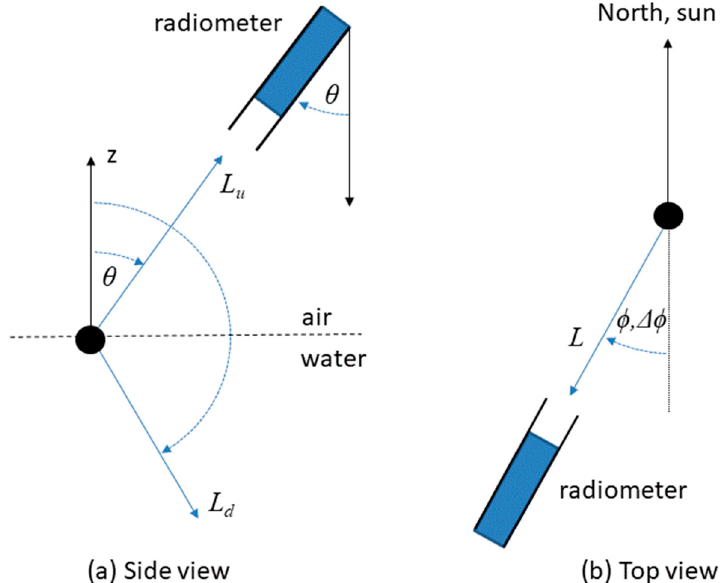
Figure 1. Nadir and azimuth viewing angle conventions illustrated for a reference system centred on the water surface (black dot). ( a ) Viewing nadir angle, θ , is measured from downward vertical axis: upward radiances are viewed at θ < π /2, downward radiances (from sky and sun) are viewed at θ > π /2. ( b ) Azimuth viewing angle, φ , and relative azimuth viewing angle, ∆ φ , are measured for viewing direction clockwise from North and sun respectively: radiance viewed by a radiometer pointing towards North has azimuth 0 and radiance viewed by a radiometer pointing towards and away from sun have relative azimuth 0 and π respectively.